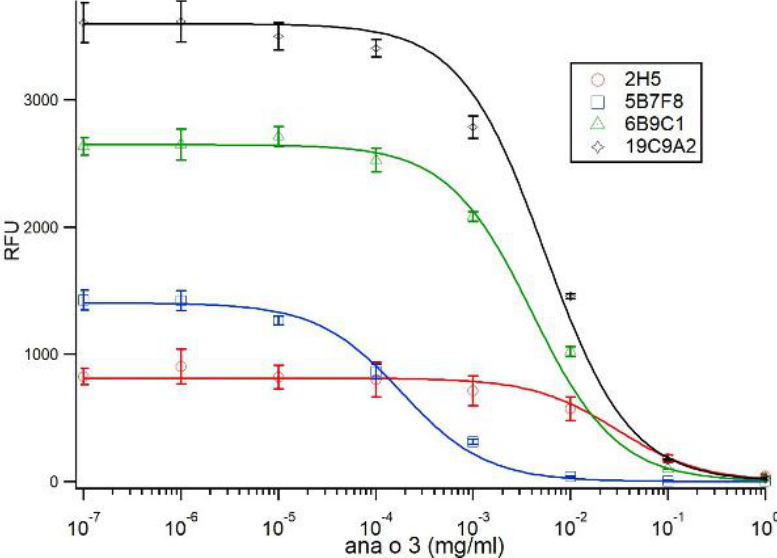
Figure 5. Competitive ELISA comparing antibody binding to purified native Ana o 3 protein. Ana o 3 protein was immobilized to the surface using a concentration of 80 µ g/mL. The concentration of competitive Ana o 3 (mg/mL) in solution is indicated on the x -axis, and relative fluorescence units (RFU) are indicated on the y -axis. Data represent the average of at least four independent samples, and error bars included show ± standard deviation. Solid lines represent fits to Equation (7), via incorporation of Equations (9) and (10).